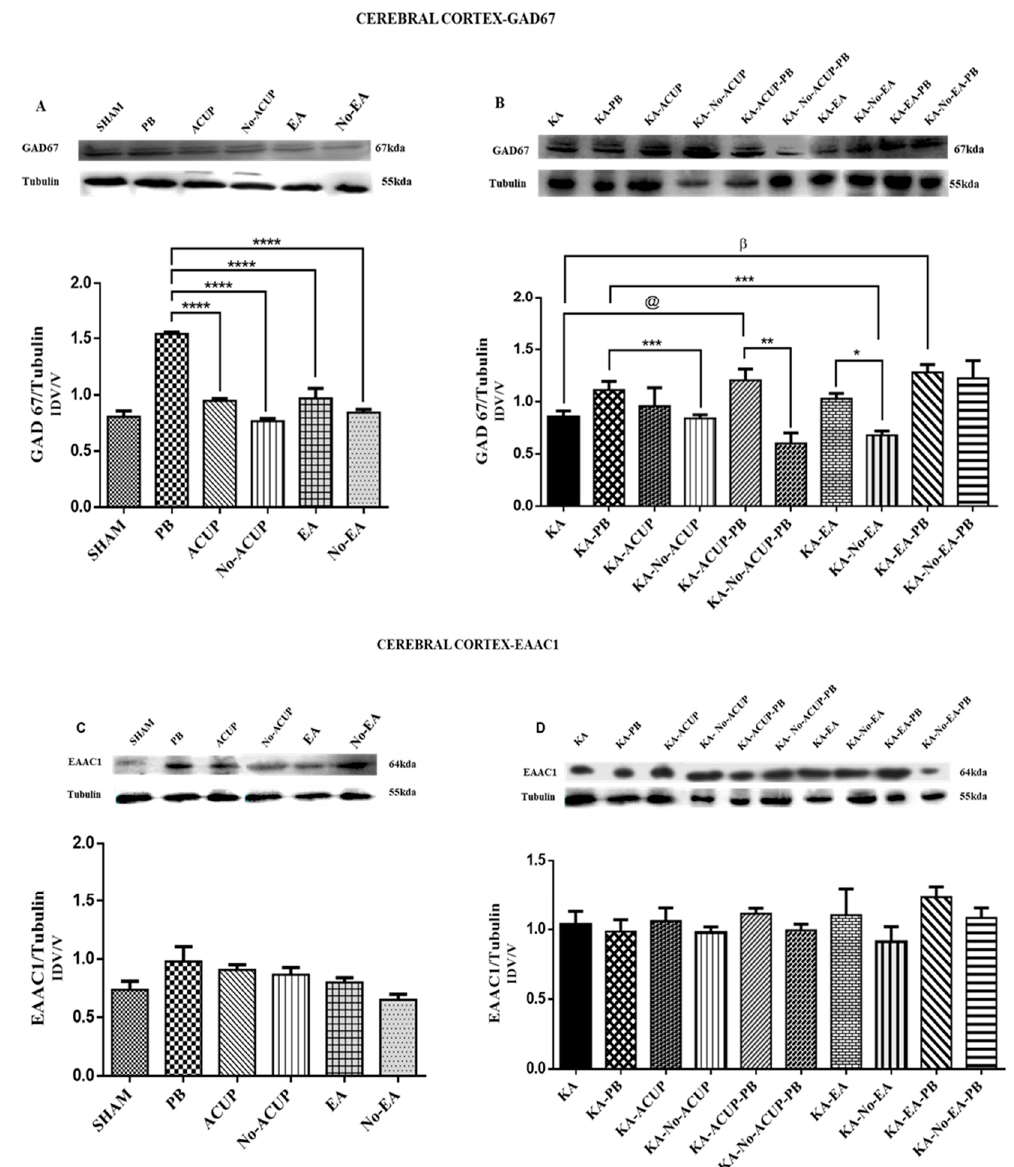
Figure 3. ( A ) Graph showing the GAD67 expression in the cerebral cortex in the control groups. The PB group showed a significant increase in GAD67 expression as compared with the ACUP, Non-ACUP, EA and Non-EA groups (**** p < 0.0001). ( B ) Graph showing the differences in the expression of GAD67 in the experimental groups: KA as compared with KA-EA-PB ( β p <0.001), KA-No-EA as compared with KA-EA (* p < 0.0019) and between the KA-ACUP-PB and KA-No-ACUP-PB (** p < 0.0066) groups; The KA-ACUP-PB and KA-EA-PB groups showed an increase in the expression of GAD67 as compared with the KA-PB (@ p < 0.05) and KA ( β p < 0.001) groups, in addition the KA-No-EA group showed a significant difference (*** p < 0.0019) as compared to KA-PB. ( C ) Graph showing the expression of EAAC1 in the cerebral cortex, where no significant differences among control groups were observed. ( D ) Graph showing EAAC1 expression in the cerebral cortex, where no significant differences were observed among the placebo and experimental groups. One-way ANOVA followed by a Bonferroni’s post hoc test, p < 0.05.